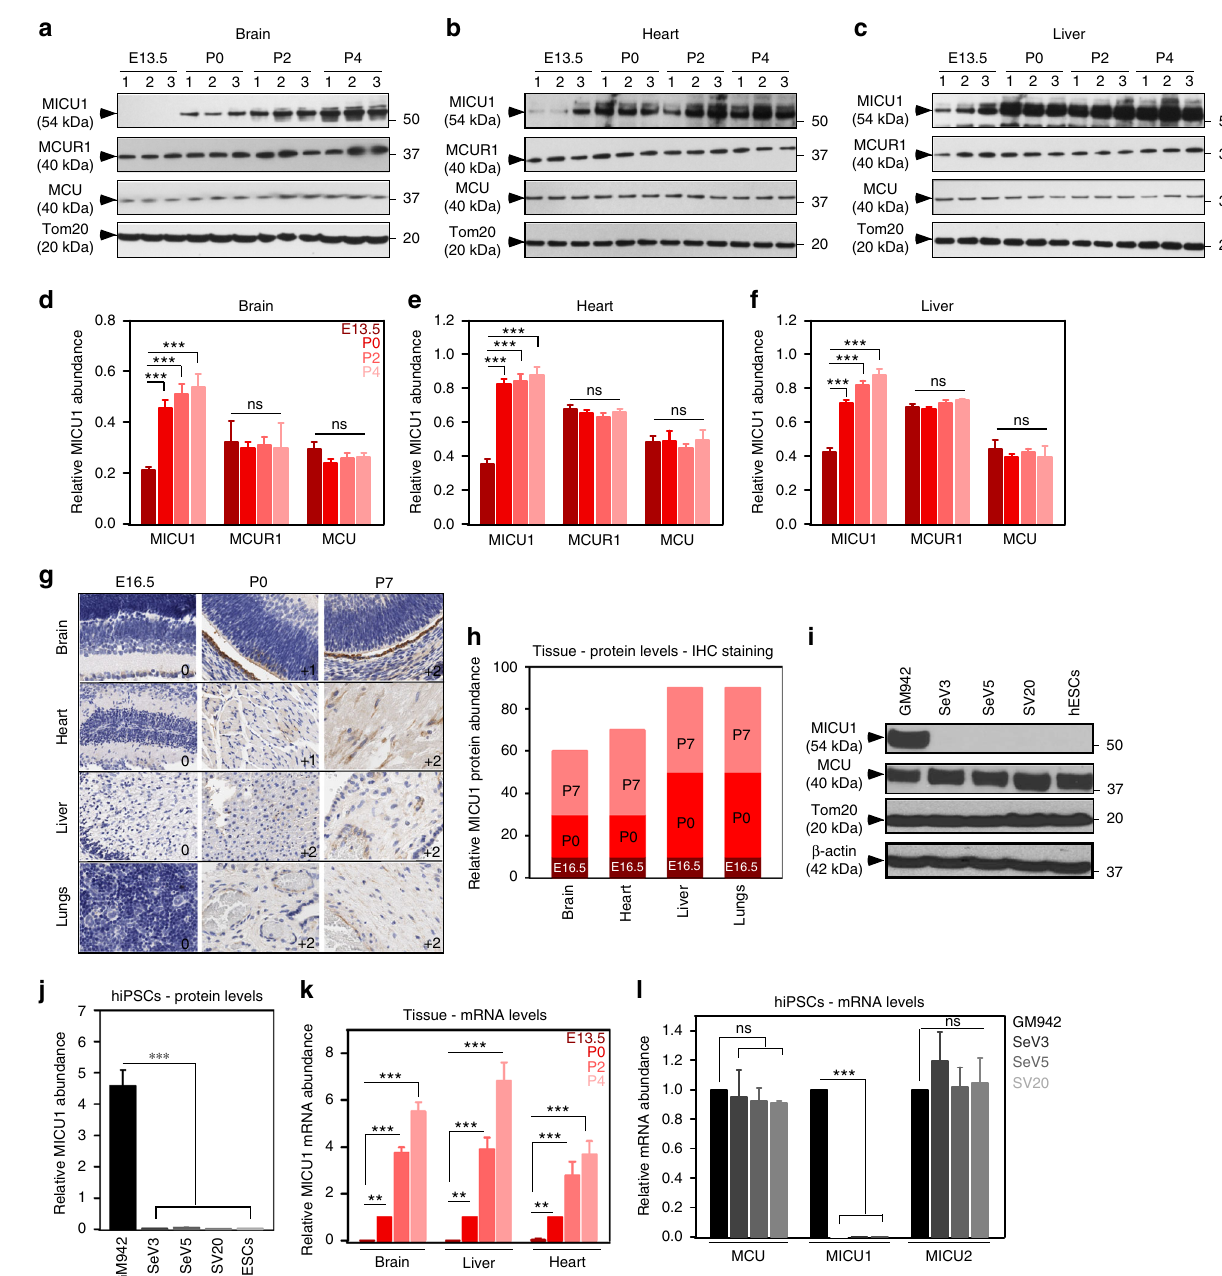
Fig. 1 MICU1 is differentially expressed during embryonic development. a – c Representative western blot for lysates from brain ( a ), heart ( b ), and liver ( c ) harvested from embryo (E13.5), and neonates (P0, P2, and P4). The western blots were probed with antibody speci fi c for MCU, MICU1, MCUR1, and Tom20. d – f Quanti fi cation of relative MCU, MICU1, and MCUR1 protein abundance from a – c . g Representative zoomed microscopic images of the tissue microarray probed with MICU1 antibody. h Quanti fi cation of MICU1 expression levels represented as percent MICU1 expression as a function of tissue staining. i Representative western blot for lysates from control fi broblasts (GM942), hiPSCs (SeV3, SeV5, and SV20), and hESCs probed with antibody speci fi c for MCU, MICU1, Tom20, and β -actin. j Quanti fi cation of relative MICU1 protein abundance from i . k Quanti fi cation of MICU1 mRNA levels in different tissues (brain, liver, and heart) harvested from embryo and neonates (E13.5, P0, P2, and P4). l Quanti fi cation of MICU1 mRNA levels in